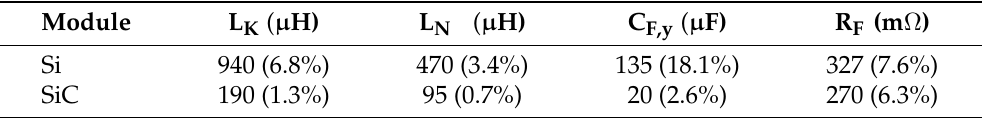
Table 6. LCL-filter nominal parameters.